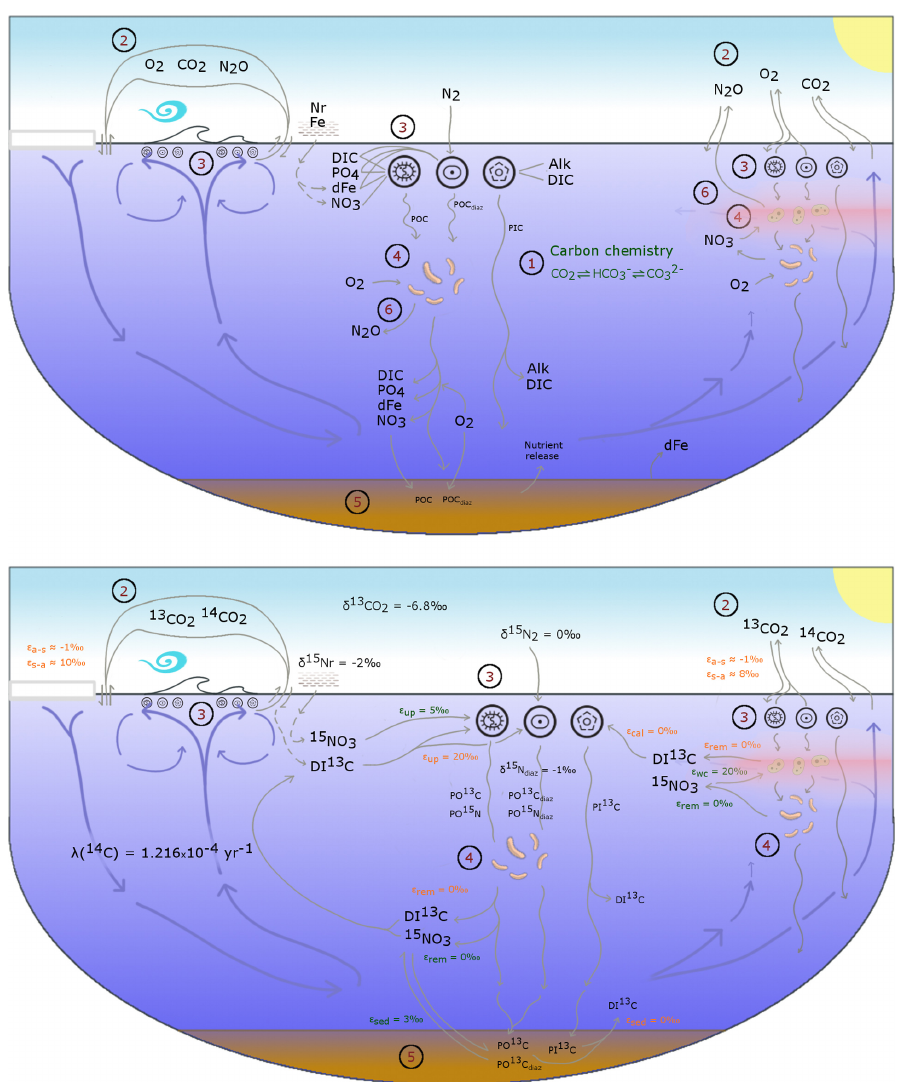
Figure 1. A conceptual representation of the ocean biogeochemical model (OBGCM). The bottom panel shows organic matter cycling in- volving the isotopes of carbon and nitrogen. (1) Carbon chemistry reactions. (2) Air–sea gas exchange. (3) Biological uptake of nutrients and production of organic and inorganic matter. Particulate organic carbon (POC) is produced by the general phytoplankton group and N 2 fixers (diazotrophs), while particulate inorganic carbon (PIC) as calcium carbonate (CaCO 3 ) is produced by calcifiers. Export of POC by the general (G) phytoplankton group and N 2 fixers (D; diazotrophs) is herein referred to as C G org and C D org (see Sect. A1 in the Appendix), respec- tively. (4) Remineralisation of sinking organic matter under oxic and suboxic conditions. (5) Sedimentary oxic and suboxic remineralisation. (6) Nitrous oxide production and